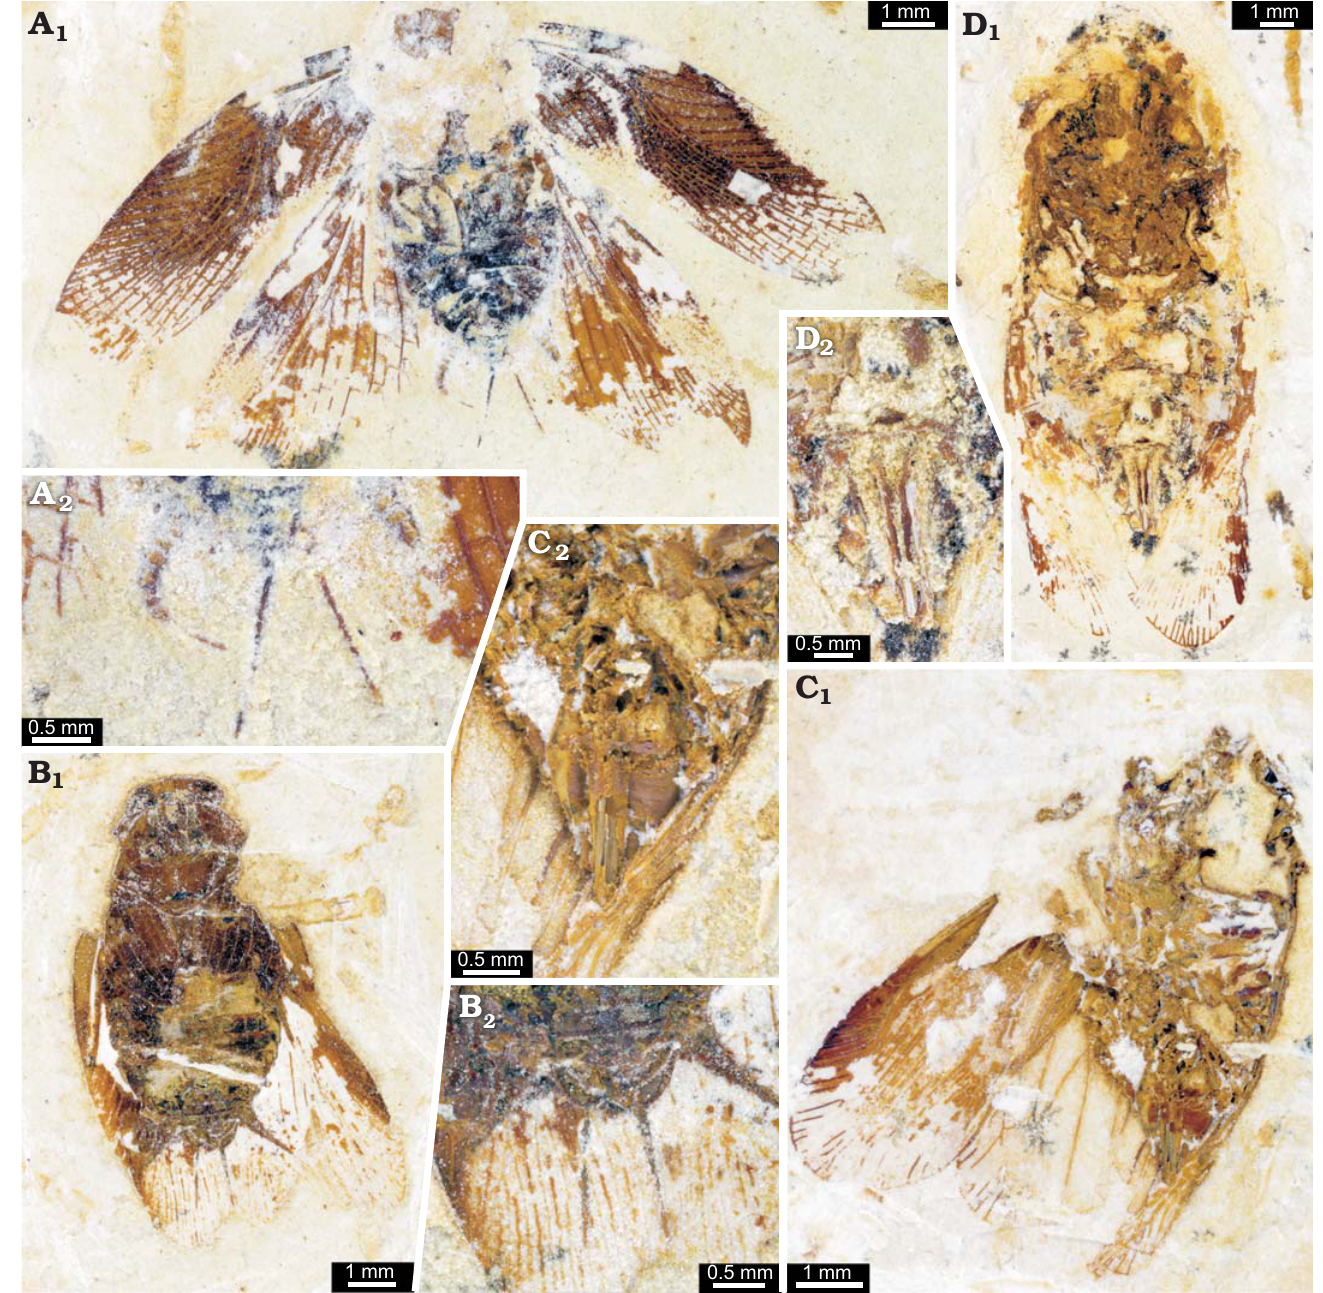
Fig. 10. Undescribed cockroaches or roachoids from the Aptian, Cretaceous Crato Formation of Brazil. A . ROMIP64635 in ventral view. B . ROMIP64634 in ventro-lateral view. C . ROMIP64636 in dorsal view. D . ROMIP64638 in ventral view. A 1 –D 1 , overviews; A 2 –D 2 , close ups of the